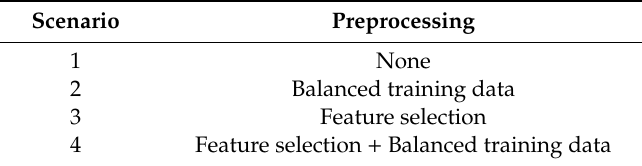
Table 6. The four considered preprocessing scenarios evaluated on the collected